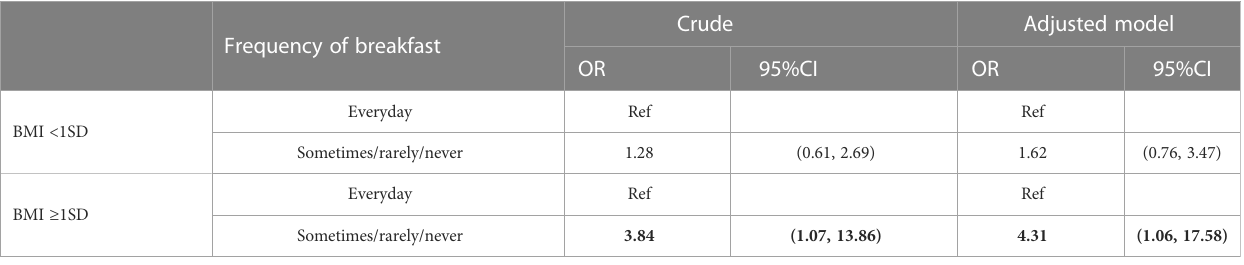
TABLE 3 Odds ratio for prediabetes and skipping breakfast strati fi ed by BMI